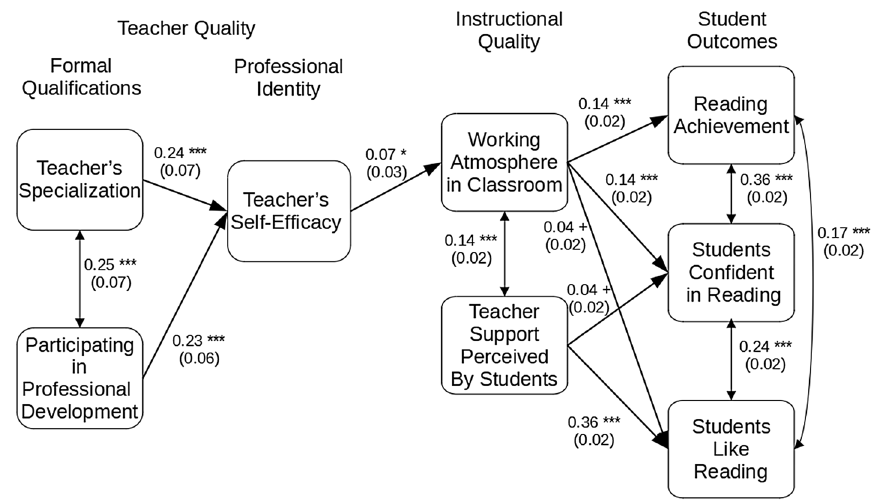
Fig. 4 Path analysis model for Finland